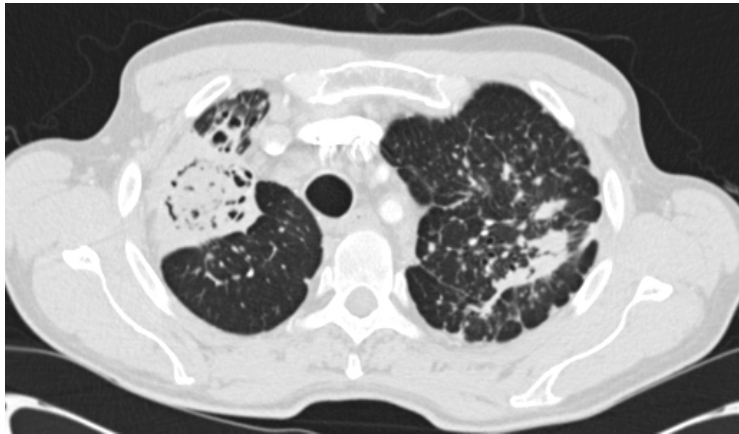
Figure 8. CT scan of SAIA demonstrating right upper lobe aspergilloma with associated pleural thickening and left upper lobe consolidation.